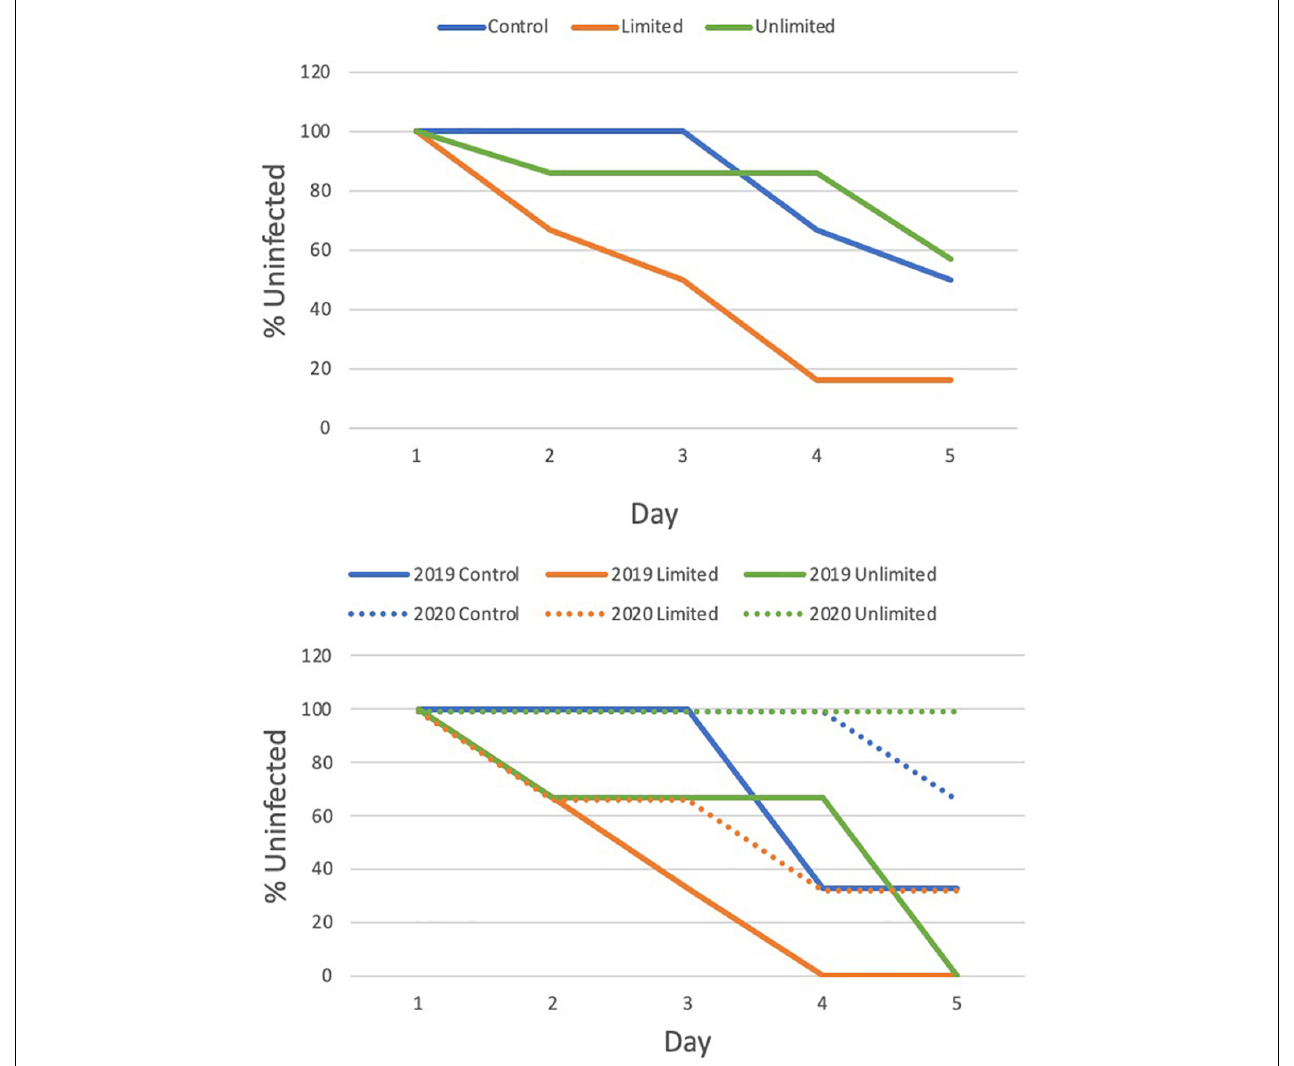
FIGURE 4 | Cox Proportional Hazards test to evaluate the effect of treatment (top) and by year (bottom) on the transmission of Stony coral tissue loss disease to healthy M. cavernosa